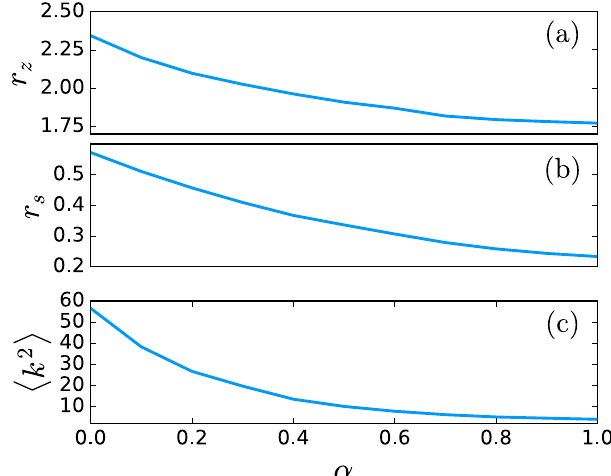
Figure 1. Influence of the second moment of the vertex degree distribution 〈 k 2 〉 on the optimization. The variance 〈 k 2 〉 is modulated with a parameter α . The plots represent in ( a ) the ratio r z = n z /( n − 1), in ( b ) the ratio r s defined in Eq. (13), and in ( c ) the variance of the vertex degree 〈 k 2 〉 . The correlation between the variation of 〈 k 2 〉 and the two ratios r z and r s is clear. The simulations have been averaged over 30 networks of n = 400 vertices with average degree 〈 k 〉 = 4 for each value of α